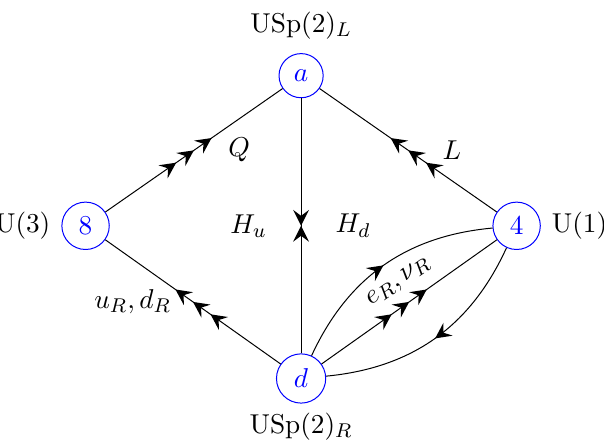
Figure 8 . Orientifolded and Higgsed quiver diagram dP 5 for the larger version of model I. After identifying USp(2) ∼ = SU(2) , this mirrors a supersymmetric version of the left-right symmetric